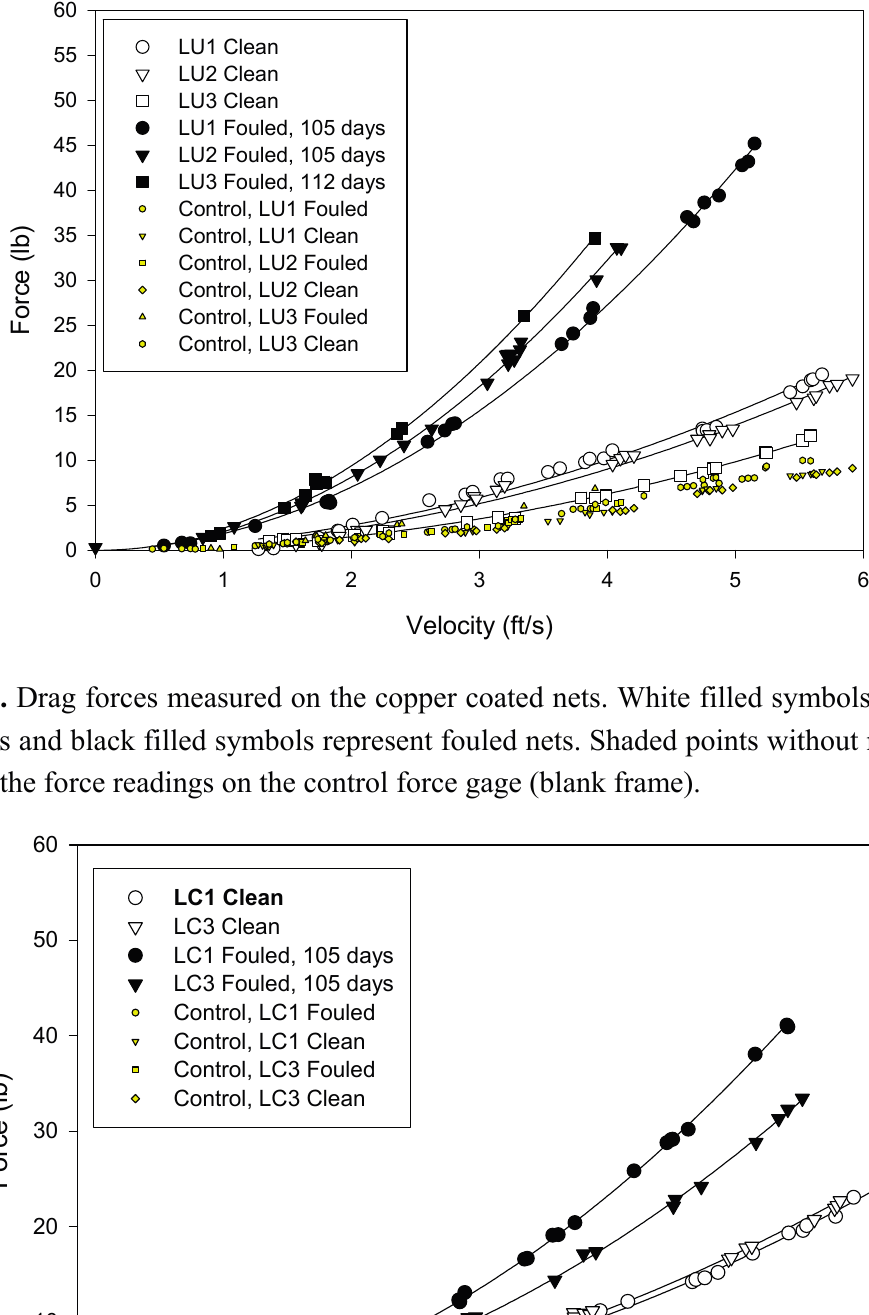
Figure 5. Drag forces measured on the uncoated nets. White filled symbols represent clean nets and black filled symbols represent fouled nets. Shaded points without regression lines are the force readings on the control force gage (blank frame).